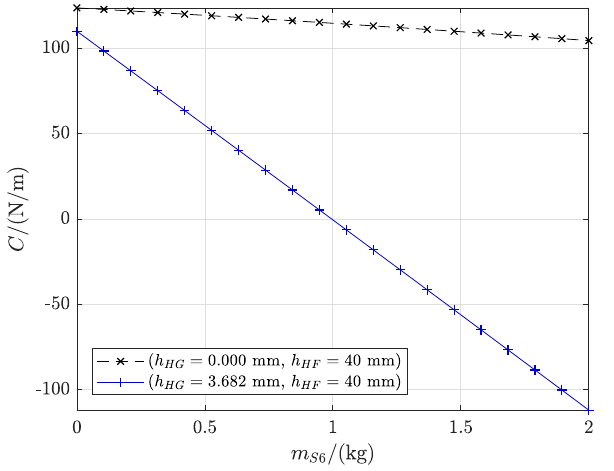
Figure 8. Linear load dependency of the stiffness C due to the h HG adjustment restricts the applicability of the adjustment to mass com- parators with small weighing